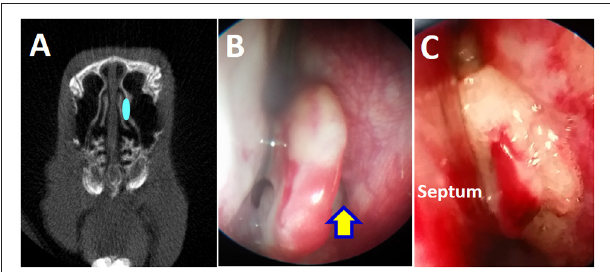
FIGURE 1 | Placement of sterile sponge in the left middle meatus. (A) Schematic drawing of sponge placement in the rabbit’s left middle meatus to block the maxillary sinus drainage pathway. (B) Endoscopic view of left middle meatus (yellow arrow). (C) Placement of sponge in the left middle